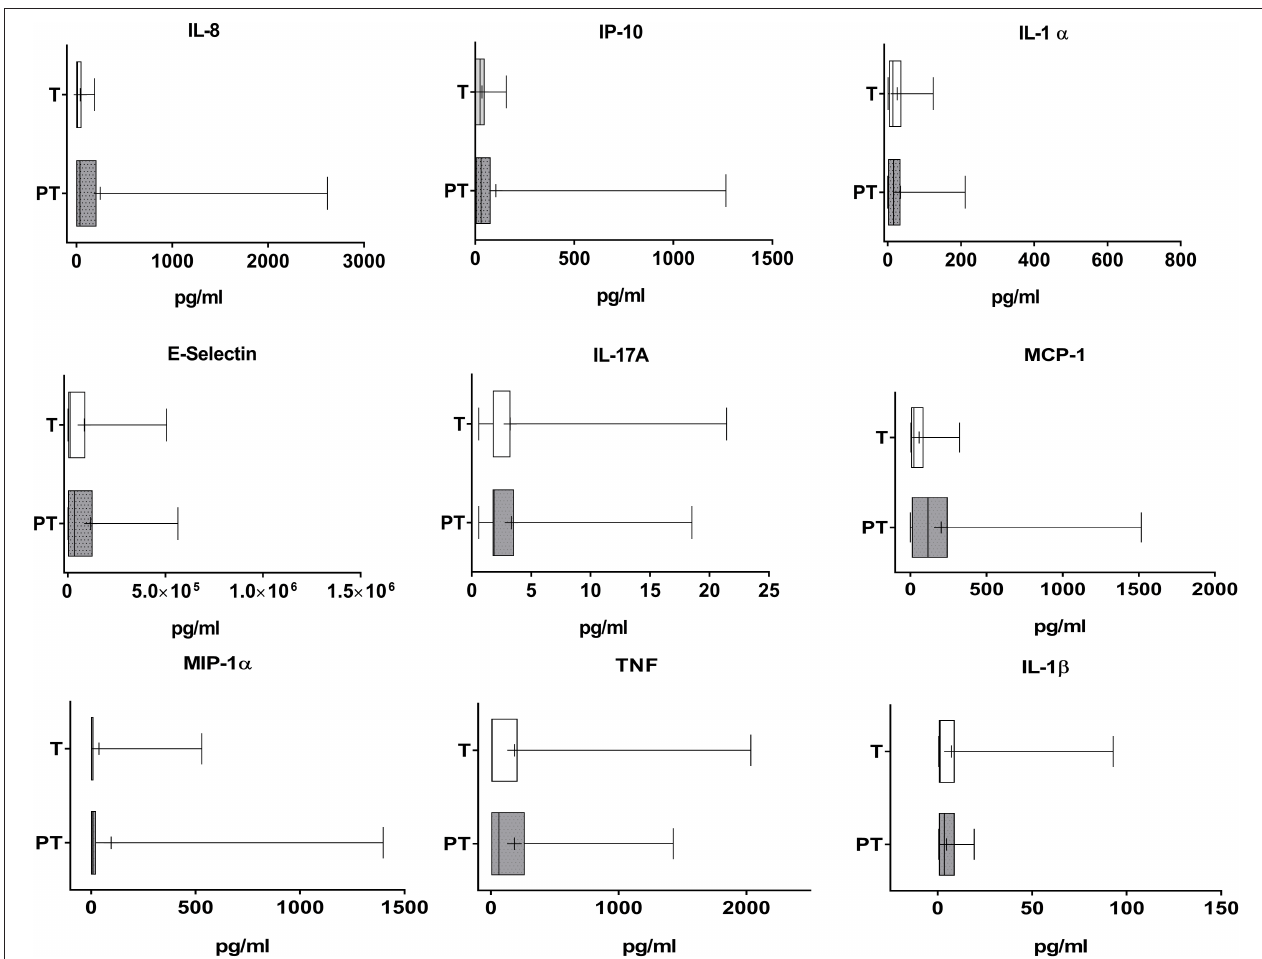
FIGURE 2 | Cytokine and adhesion molecules levels in the meconium of T and PT newborns. IL-8, IP-10, IL-1 α , E-selectin, IL-17A, MCP-1, MIP-1 α , TNF, and IL-1 β are shown. + p < 0.05 vs.